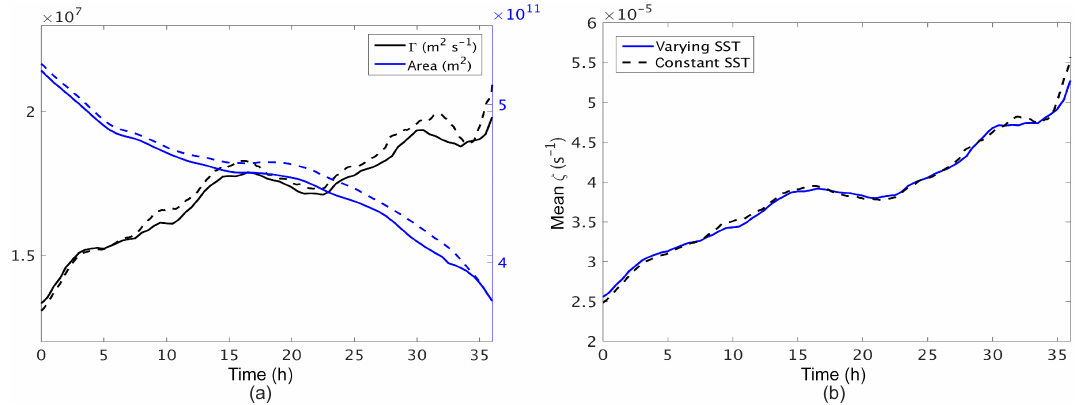
Figure 7. The circulation (m 2 s − 1 ) and area (m 2 ) are shown in panel (a) as black and blue curves, respectively, for the varying SST (solid lines) and constant SST (dashed lines) WRF simulations, respectively. The mean vorticity (s − 1 ) is shown in panel (b) for the varying SST simulation (solid) and constant SST simulation